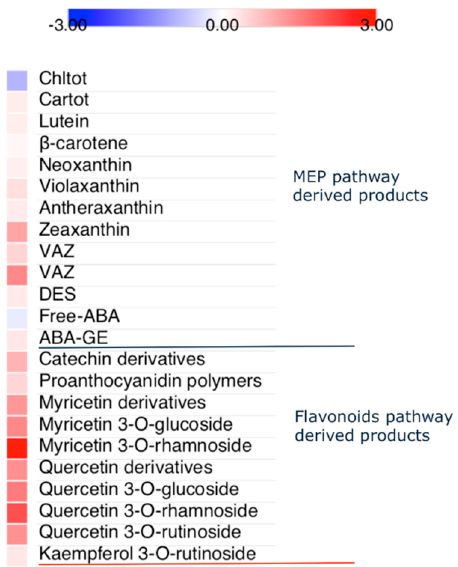
Figure 4. Changes in isoprenoid and flavonoid-derived products in C. incanus leaves adapted to shade or full sunlight. Fold changes, on log 2 basis, denotes sun to shade metabolite concentration (on leaf dry mass basis).